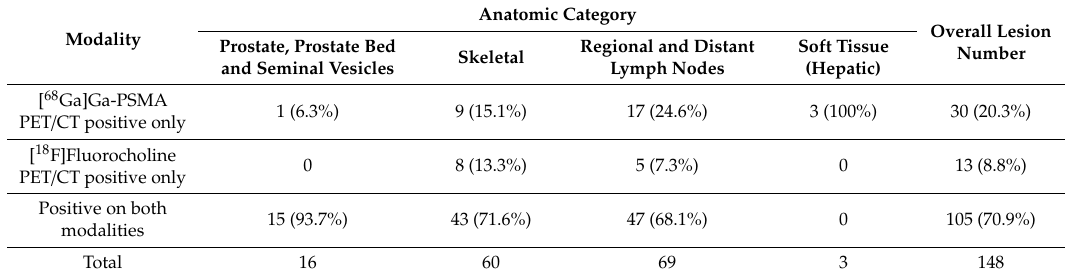
Table 1. Number of lesions detected by both and exclusively by each modality according to anatomical regions.